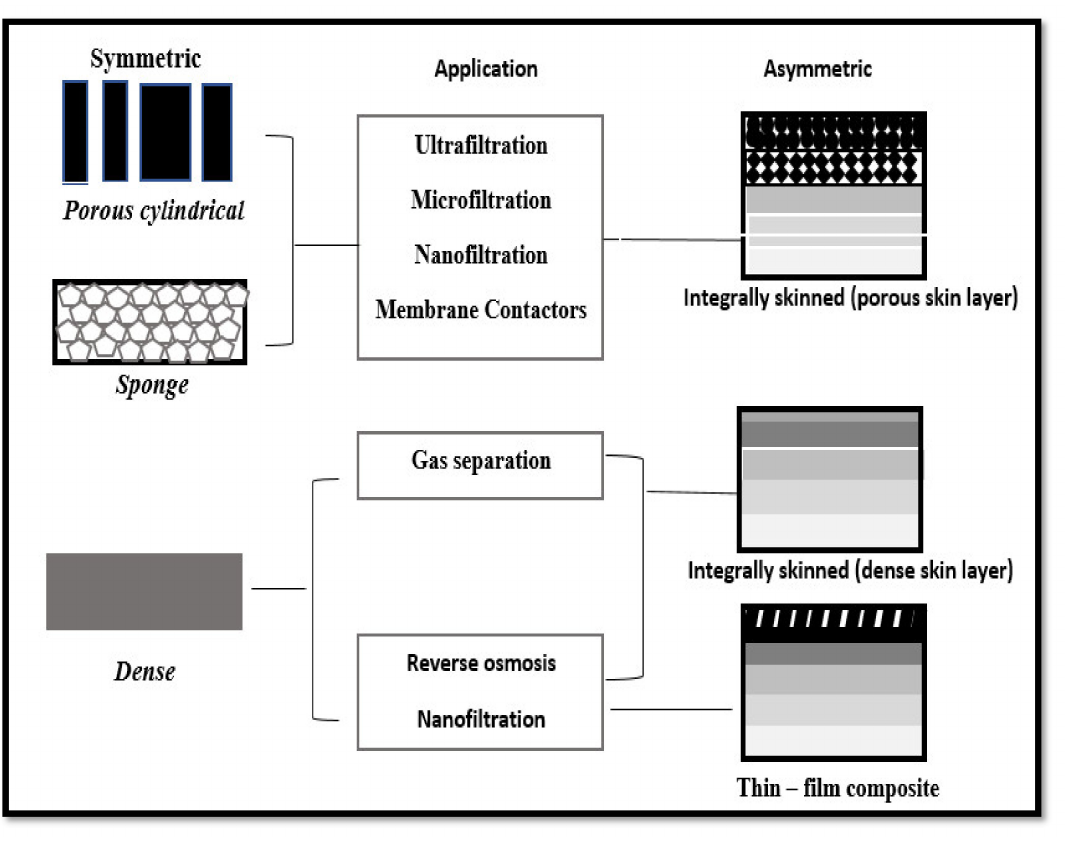
Figure 7. Membrane types are classified based on their bulk structure (symmetric or asymmetric), morphology (porous, sponge, dense, integrally skinned, thin-film composite), and application.